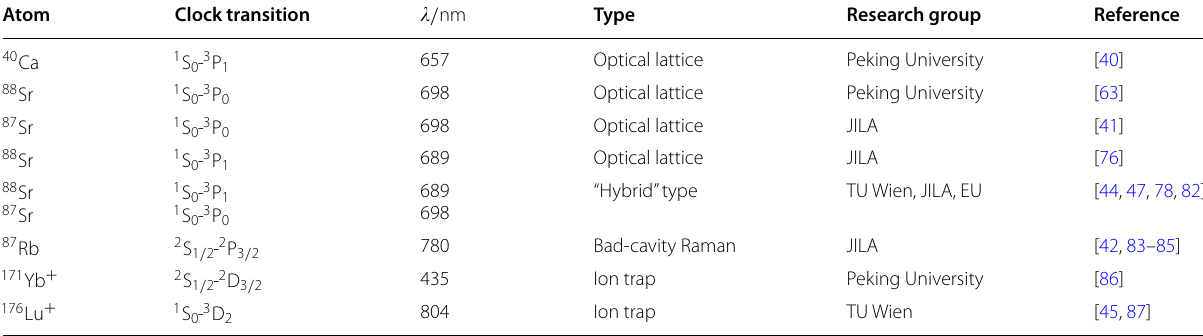
Table 2 Properties of selected three-level AOC, including the clock transitions, their wavelengths, and working types. The corresponding research groups and references are also